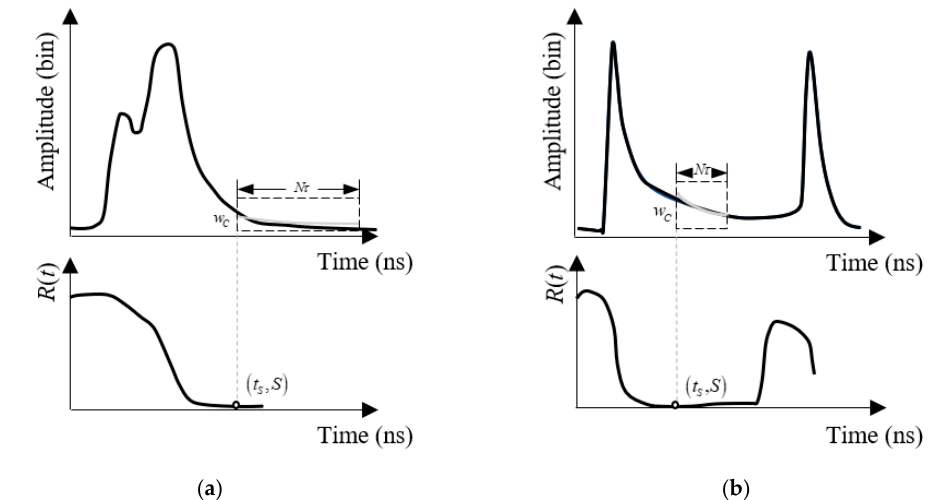
Figure 5. R ( t ) of ( a ) a shallow water (SW) waveform with a large S of 4220.5 and ( b ) a deep water (DW) waveform with a small S of 133.4.